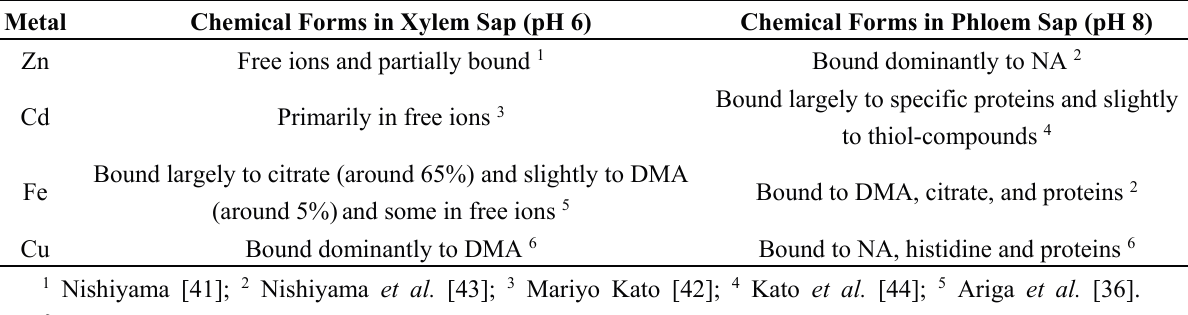
Table 3. Chemical forms of Zn, Cd. Fe, and Cu in xylem and phloem saps from rice plants. Metal speciation analyses in xylem and phloem saps were conducted by using SE-HPLC, ICP-MS, CE-MS, and ESI-TOF